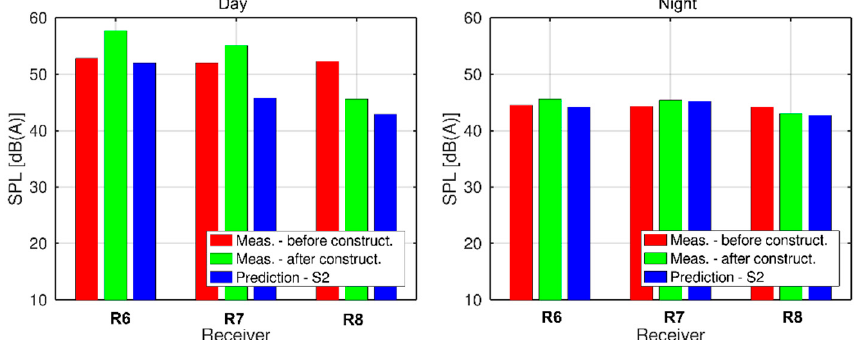
Figure 19. Comparative analysis between the predicted and the measured sound levels in the “hot spot” receivers for the day and night periods.